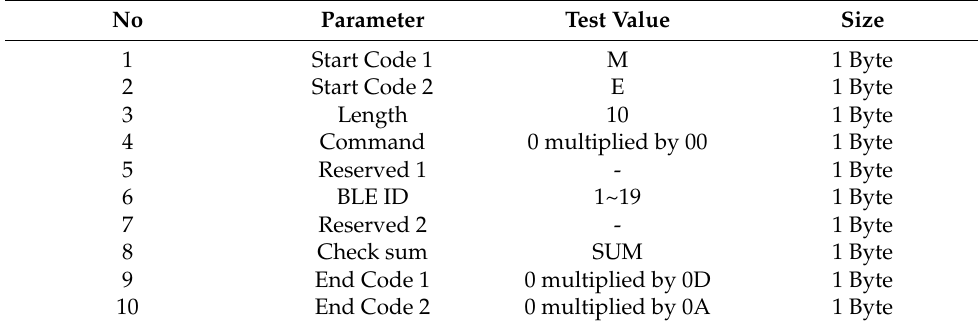
Table 2. Central processor request